Question: Briefly state, in one sentence, what is plotted here.
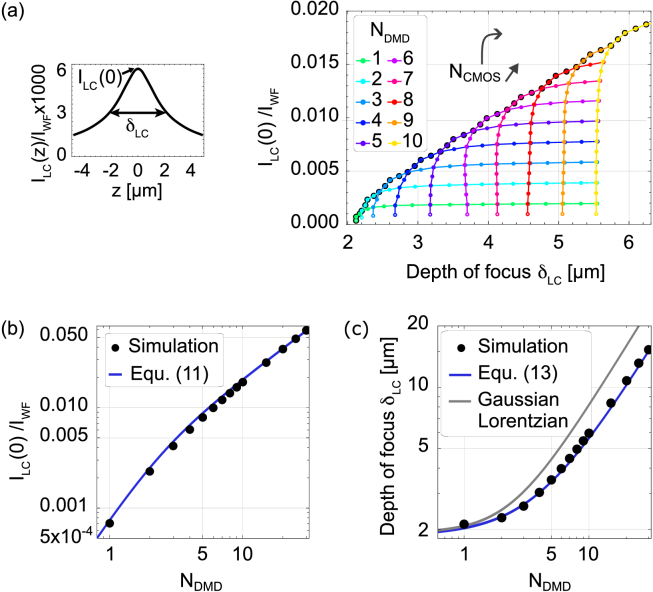
Answer: Line confocal sectioning in coherent reflection microscopy: numerical and analytical analysis. (a), left, example intensity profile in LC coherent reflection microscopy, defining graphically the parameters I LC ( 0 ) and δ LC ; right, simulated I LC ( 0 ) / I WF plotted against δ LC as a function of the number of simultaneously detected lines N CMOS (single colour, starting from empty marker) and of the number of illuminated lines N DMD (colour-coded). The lines are a guide for the eye. Optimal (intensity, resolution) pairs are outlined in black and are obtained for N CMOS ≈ a M l s × N DMD . In (b-c), only this matching condition is plotted. (b), simulated normalised intensity as a function of N DMD extracted from (a) (black dots), and theoretical predictions from Equ. ( 11 ) (blue line) showing excellent agreement. Both are normalised to the full field case, corresponding to N tot = 1024 sCMOS lines in our setup. (c), simulated depth of focus δ LC as a function of N DMD extracted from (a) (black dots), and theoretical predictions from Equ. ( 13 ) (blue line) showing also excellent agreement. Theoretical prediction using the classical Gaussian-Lorentzian approximation overestimates the depth of focus (gray line).